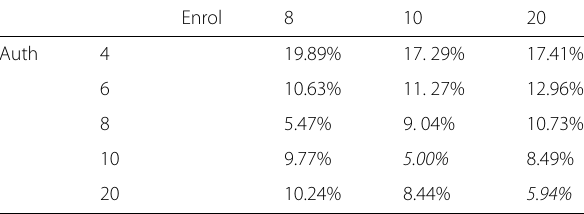
Table 6 Number of digits in an enrolment video (Enrol) against number of digits in authentication video (Auth)